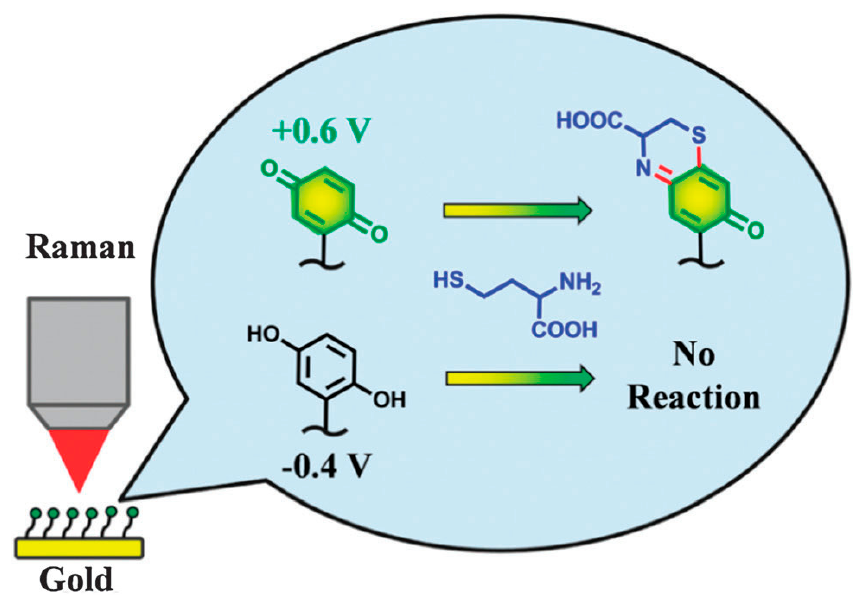
Figure 5. The mechanism of quinone hydroquinone-SAM on a gold electrode surface. Reprinted with permission from Ref. [68]. (Copyright, ACS, 2013).